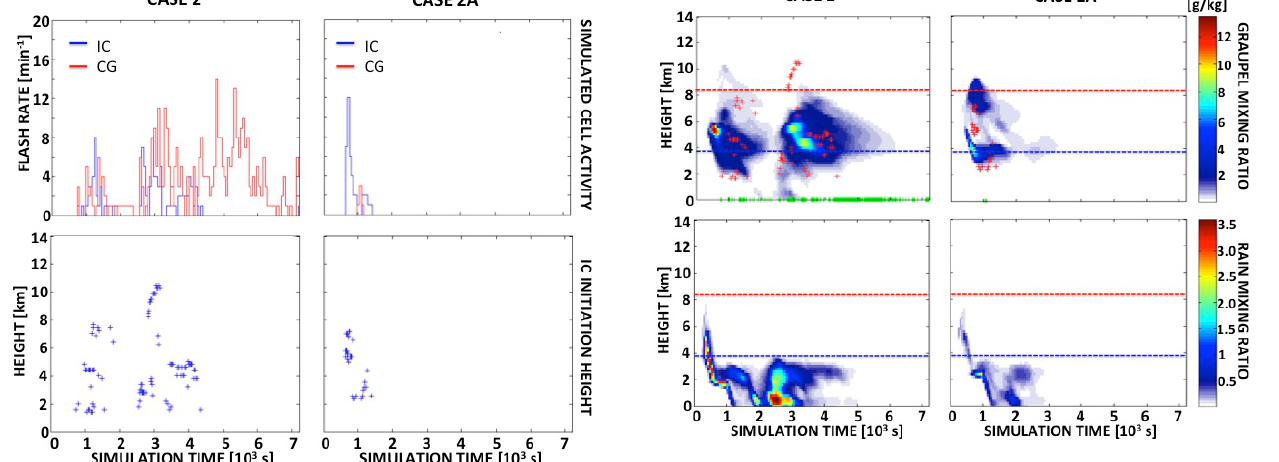
Fig. 14. Comparison between the evolution of the simulated light- ning activity for Case 2 (left column) and Case 2A (right column). The top panels, showing the IC (red line) and CG (blue line) flashes produced by the EMTM in one-minute sampling intervals during the 7000s simulation time, have been built as described in Sect. 4 – also note that the histograms for the control run (Case 2) have been already shown in Fig. 11 and are duplicated here for convenience.